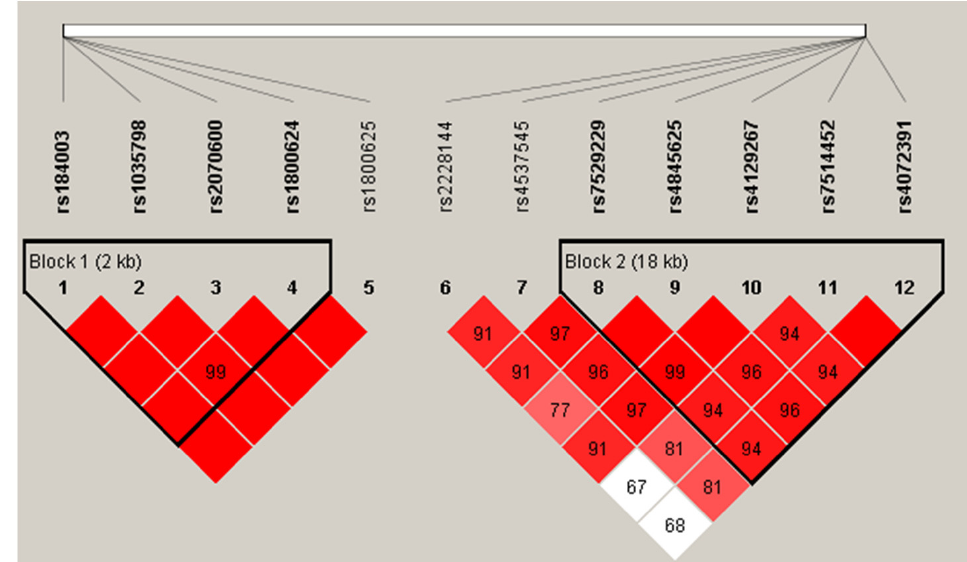
Figure 2. Haplotypes in AGER gene and IL6R gene. Two haplotypes were identified by haploview software. AGER gene: rs184003-rs1035798-rs2070600-rs180062; IL6R gene: rs7529229-rs4845625-